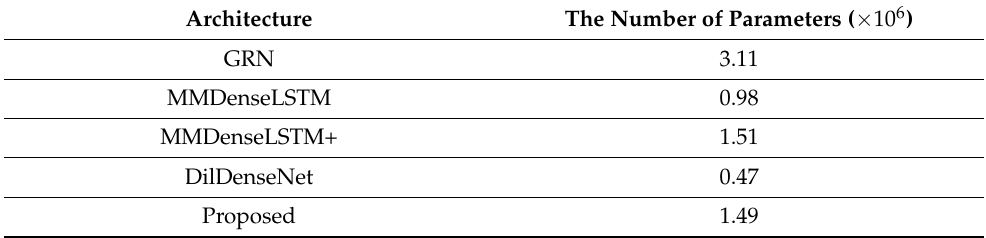
Table 4. Number of parameters for each architecture in this experiment.